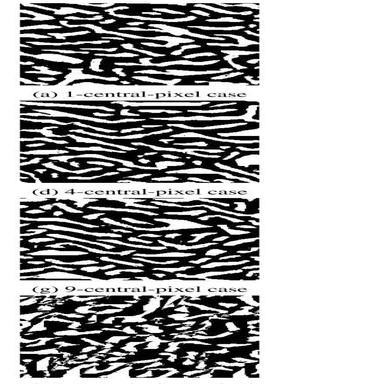
Representative reconstruction results (image size: 200 × 200 pixels) by using the proposed method and Bandstand's method.